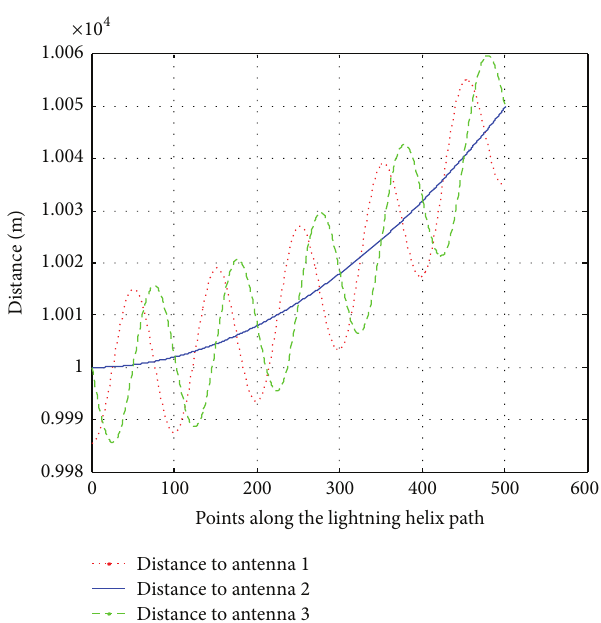
Figure 15: Computed distance between points along a helical path of lightning and the antennas at the sensor station.